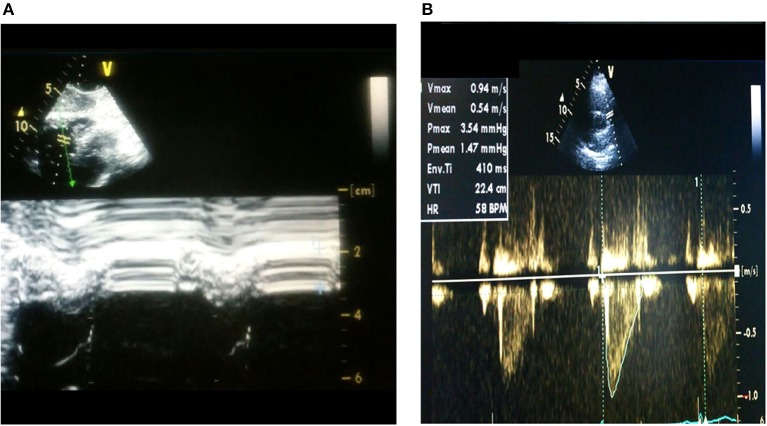
Representative echocardiographic images (A) right ventricular hypertrophy and (B) Acceleration curve of pulmonary flow at pulmonary artery outflow tract.